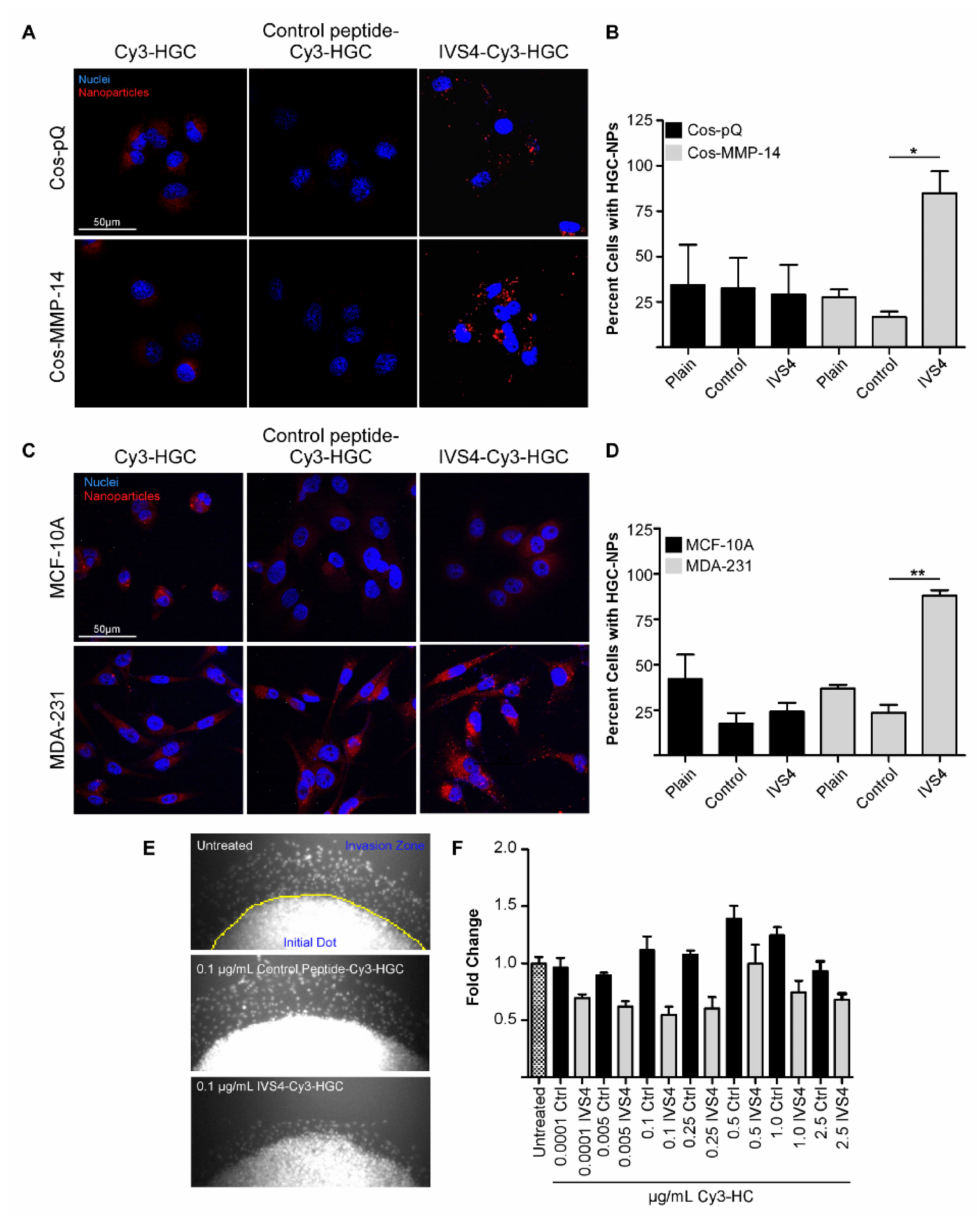
Figure 2. IVS4 peptide confers an uptake advantage to MMP-14-expressing cells. ( A , B ) Delivery of 1.0 µ g/mL NPs for 8 h to normal Cos-1 cells that only express vector control: little to no NPs of any type were internalized. In Cos-1 cells stably expressing MMP-14, however, the nanoparticles bearing the IVS4 peptide were internalized more efficiently (* p < 0.05 by one-way ANOVA, counts performed on five images per condition). ( C , D ) While no differences are observed in uptake of 2.5 µ g/mL Cy3-HGC or control peptide-Cy3-HGC NPs for any cell type, the IVS4-Cy3-HGC NPs were taken up more efficiently after 24 h only in MDA-MB-231 cells (** p < 0.001 by one-way ANOVA, counts performed on five images per condition). ( E , F ) The IVS4 peptide-conjugated NPs can significantly attenuate migration of MDA-MB-231 cells ( p < 0.01 by two-way ANOVA). These experiments were performed in triplicate with combined data